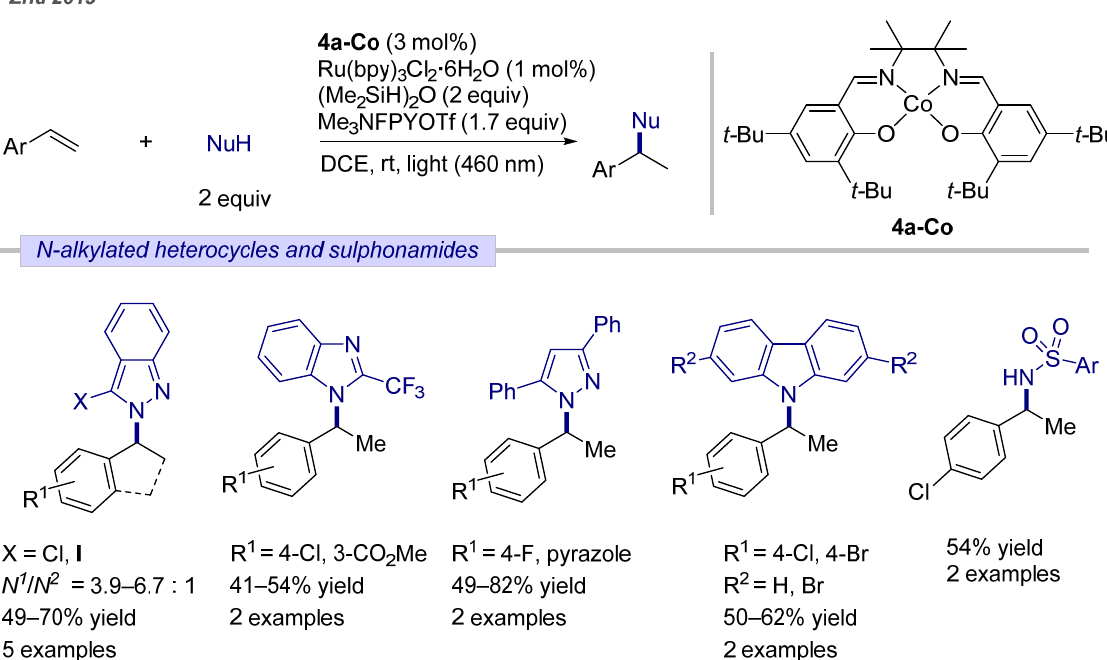
Figure 14. Markovnikov intermolecular hydroamination of N -heterocycles and sulfonamides and styrenes based on visible-light-mediated Co/Ru dual catalysis. rt = room temperature.